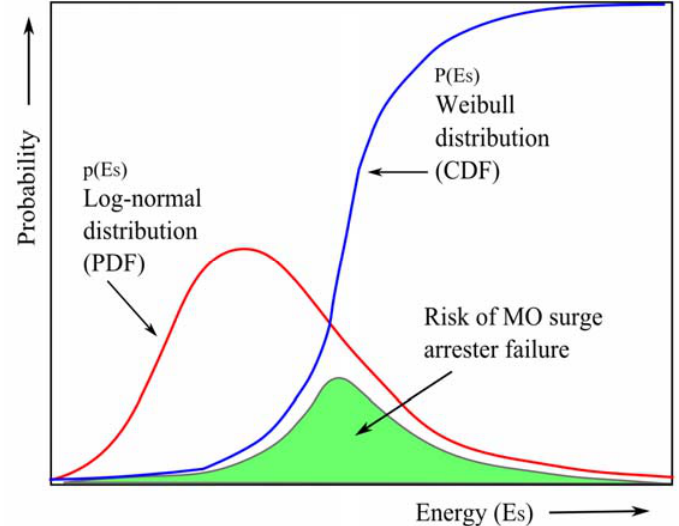
Figure 7. Graphical illustration of the statistical approach to the MO surge arrester risk of failure